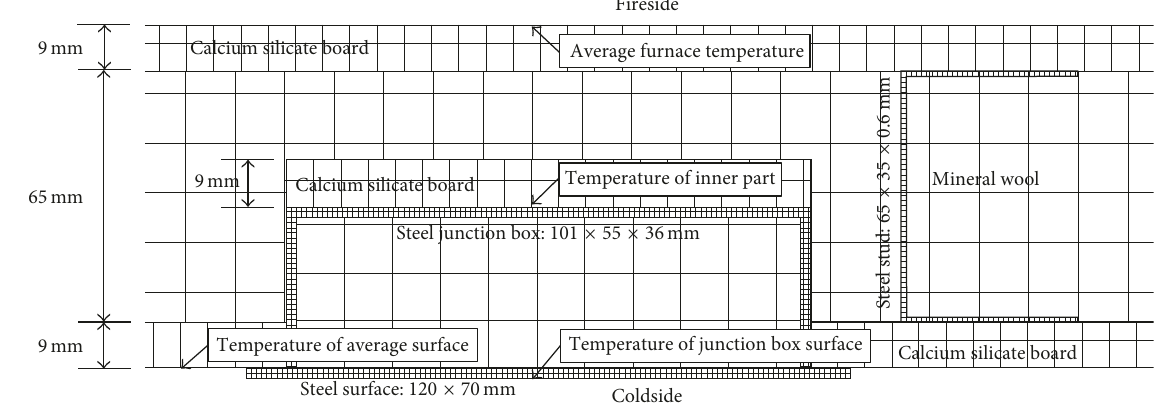
Figure 5: Cross section of the wall with indication of numerical modelling and the thermocouple position in Test 3.